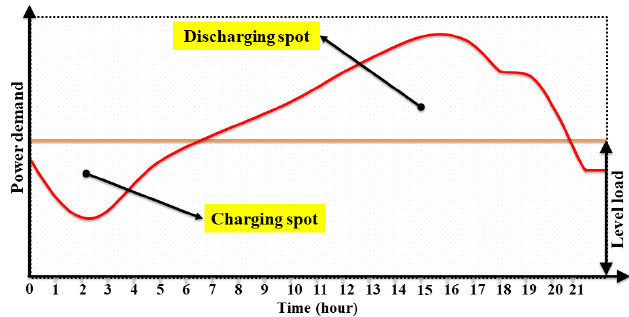
Figure 6. Load leveling of ESS application [31].